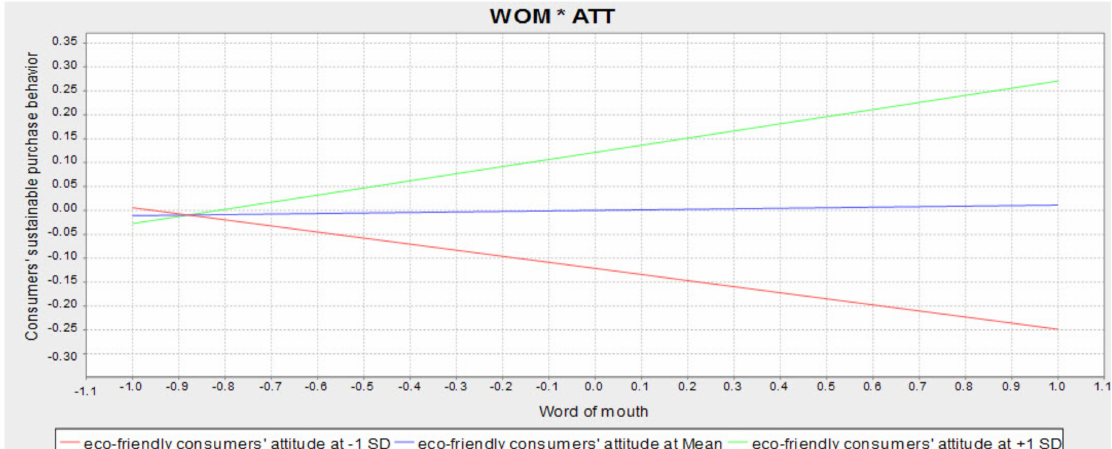
Figure 4. Moderating effect (Word of Mouth*Attitude-Consumer Sustainable Purchase